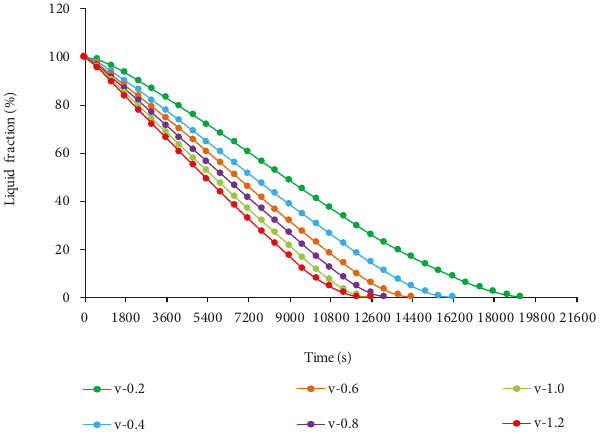
Figure 16: E ff ects of inlet velocity of HTF on liquid